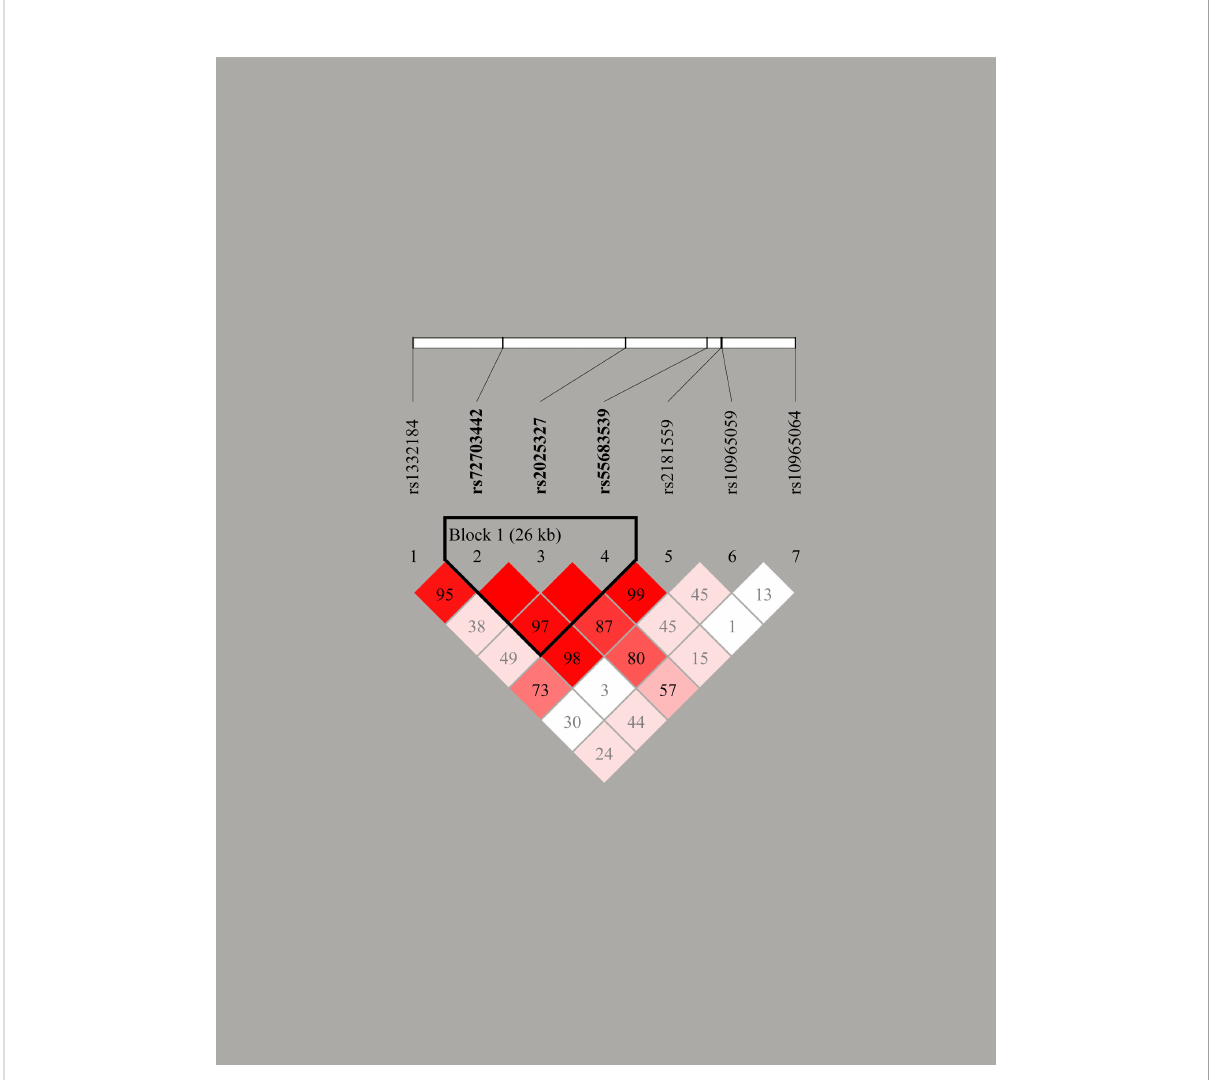
FIGURE 1 Linkage disequilibrium (LD) plots containing three polymorphisms from MIR31HG. Block 1 includes rs72703442, rs2025327, and rs55683539. The numbers inside the diamonds indicate the D ’ for pairwise